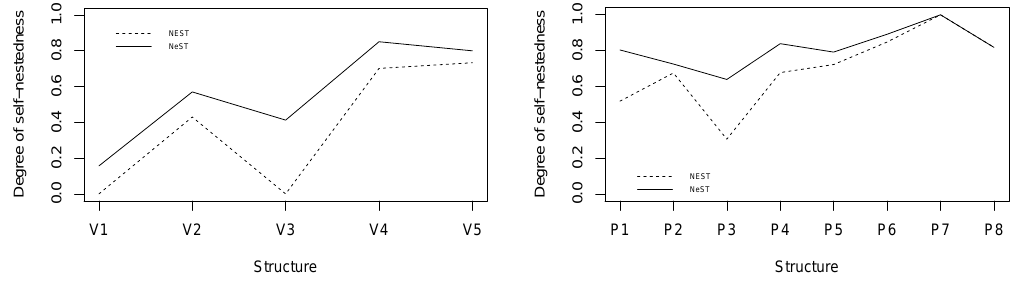
Figure 12. Degree of self-nestedness measured by δ NEST different substructures appearing in the rice